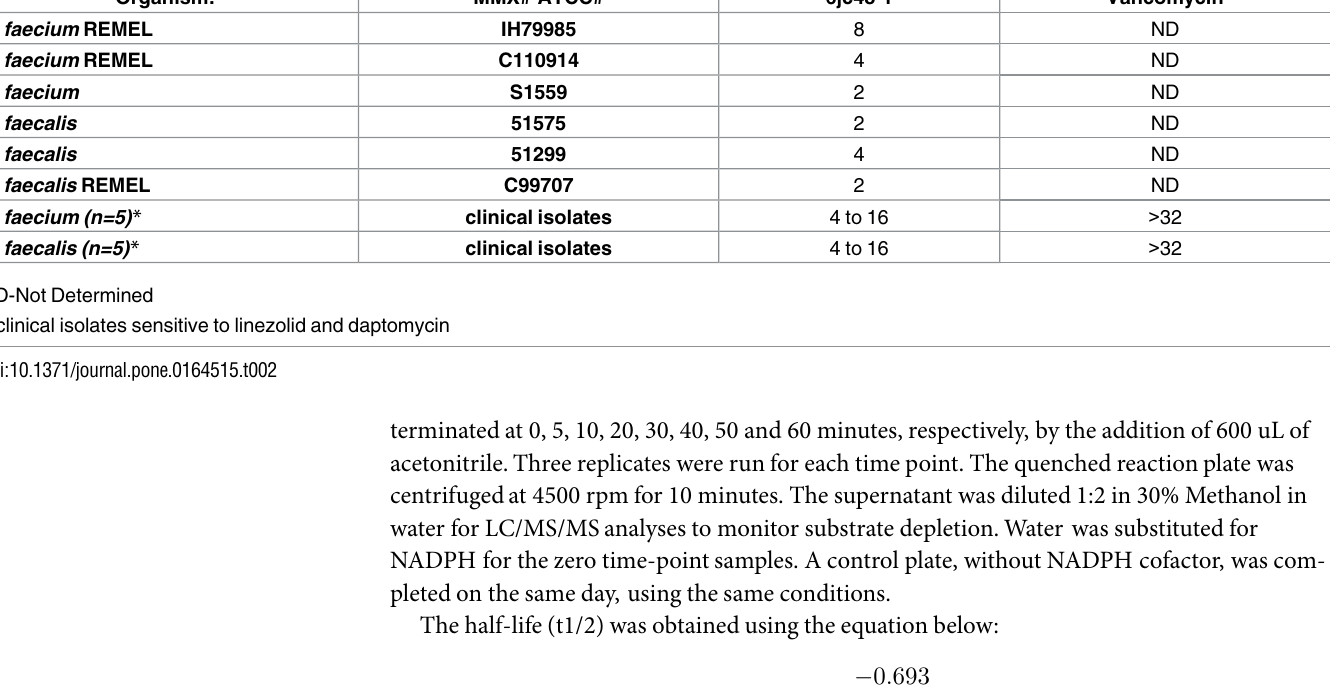
pleted on the same day, using the same conditions.